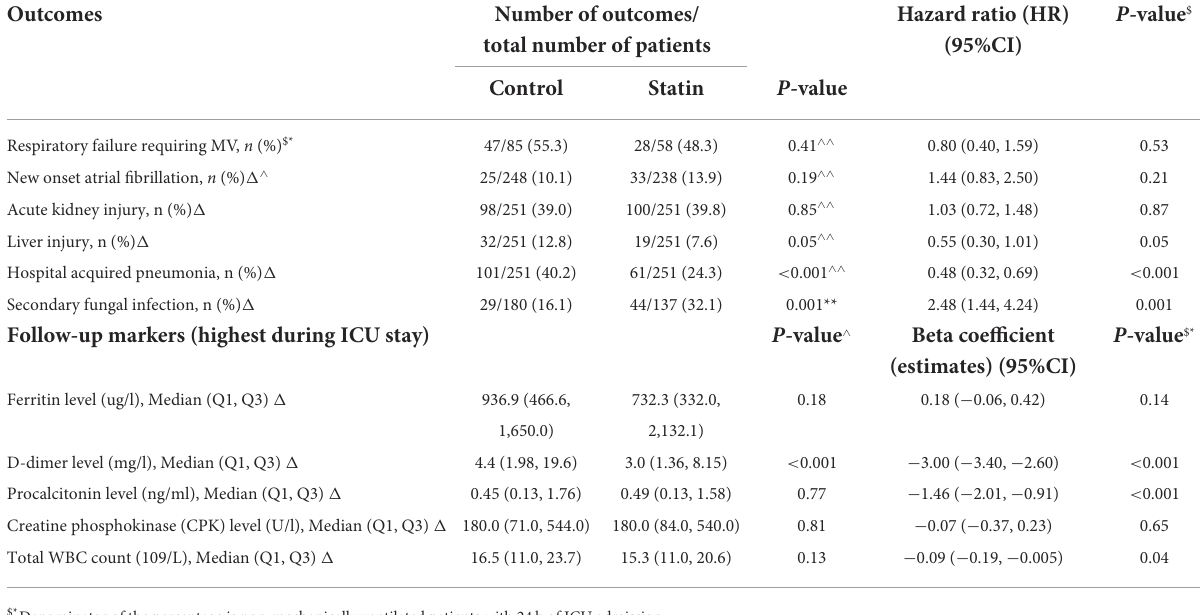
TABLE 5 The ICU complications of critically ill patients with COVID-19 during